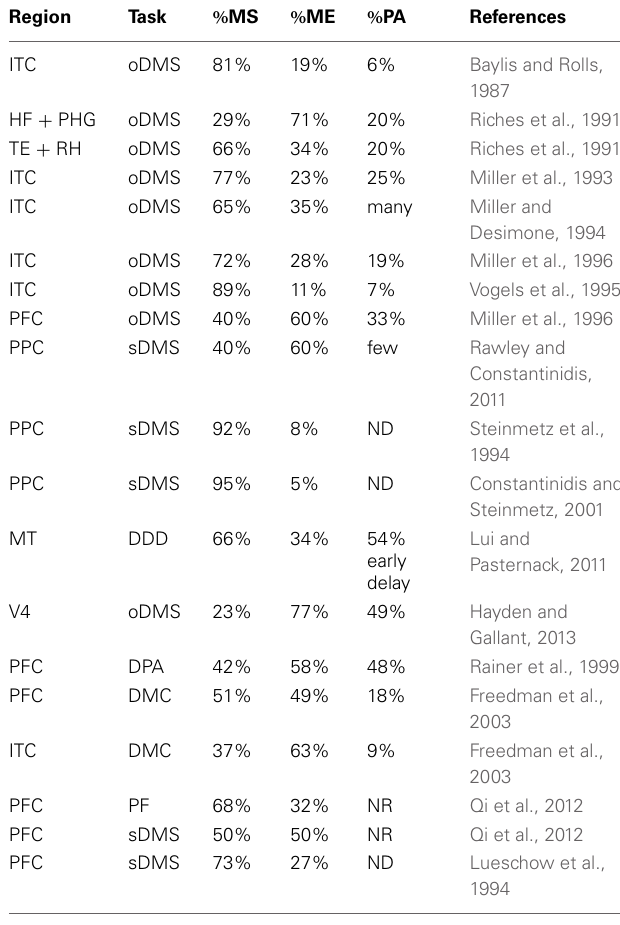
Table 1 | First column: cortical region of recordings. Second column: task; oDMS = object DMS; sDMS = spatial DMS; DDD = delay direction discrimination; DPA = delay paired associate; DMC = delay match to category; PF = passive fixation. Third column: percentage of differentially responsive neurons showing suppression. Fourth column: percentage of differentially responsive neurons showing enhancement. Fifth column: percentage of all recorded neurons showing persistent